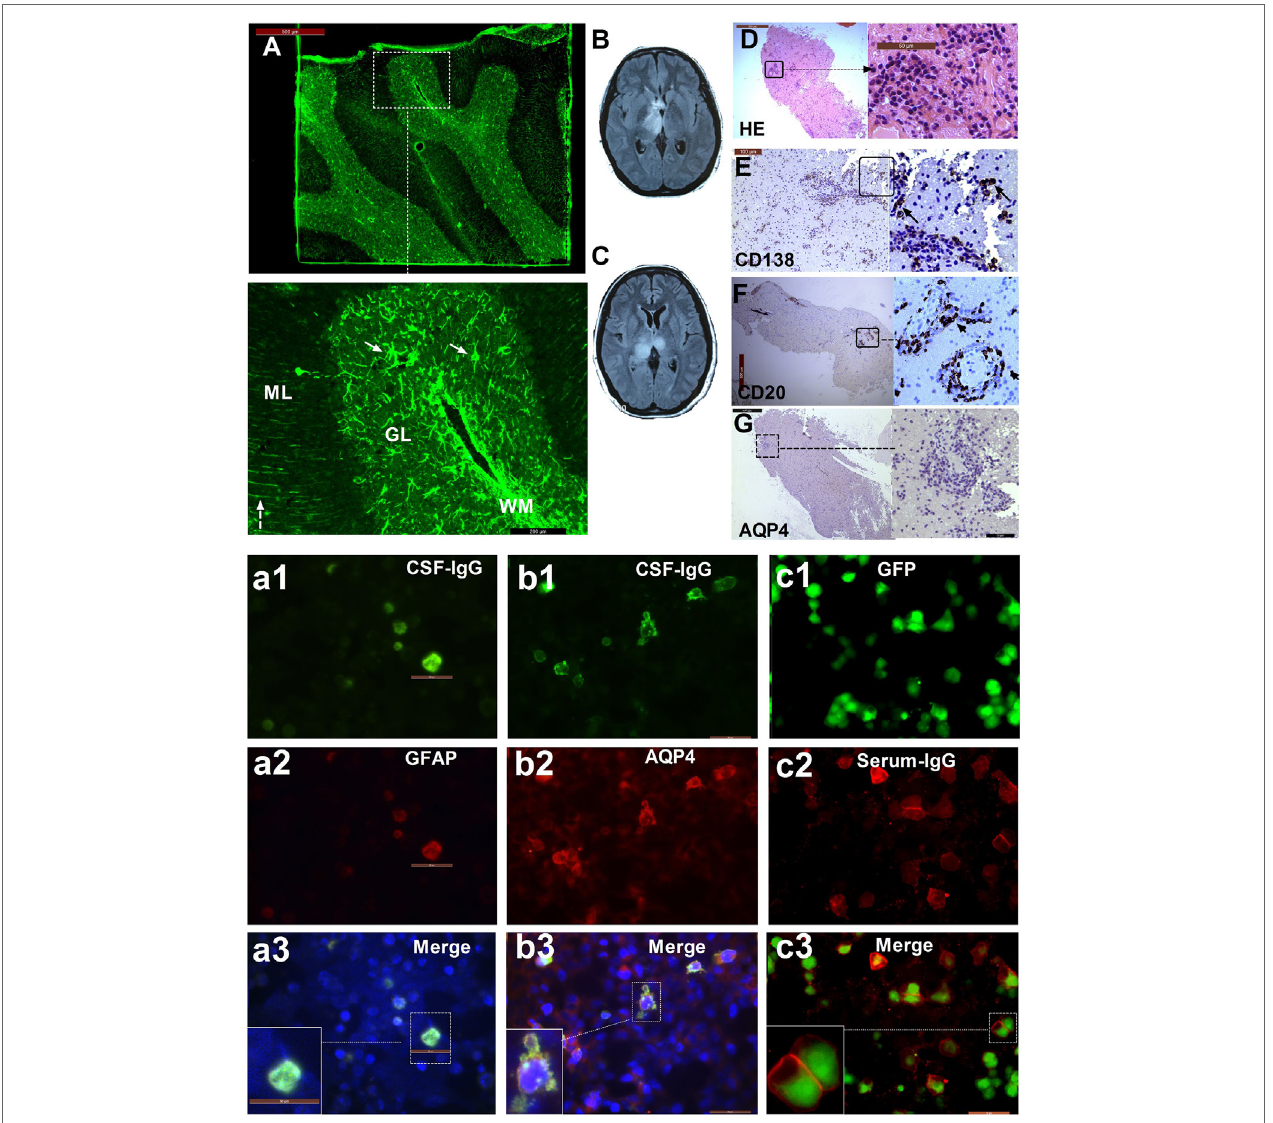
FigUre 1 | The patient with three types of antibodies: immunofluorescence pattern, magnetic resonance imaging (MRI), and neuropathological features. (a) Cerebellum section showing strong immunofluorescence in astrocytes (arrow) in white matter (WM), the granular layer (GL), and the molecular layer with a Bergmann radial pattern (dashed arrow); (a1) CSF-IgG bound to HEK293 cells transfected with GFAP ε , showing the microfilament pattern (green); (a2) glial fibrillary acidic protein (GFAP) α (red) expression in HEK293 cells transfected with GFAP α , showing the microfilament pattern; (a3) merged image from (a1) and (a2) . (b1) CSF-IgG bound to HEK293 cells transfected with AQP4 (green); (b2) AQP4-M23 protein (red) expression in HEK293 cells transfected with AQP4; (b3) merged image from (b1) and (b2) . (c1) HEK293 cells stably expressing green fluorescent protein (GFP)-tagged myelin oligodendrocyte glycoprotein (MOG) isoforms (green); (c2) transfected cells immunostained with human IgG (red); (c3) merged image from (c1) and (c2) . (B) An MRI scanning shows lesions in the left thalamus and anterior commissure at the first attack. (c) Bilateral thalamus lesions at the third attack. (D) Hematoxylin-eosin staining of brain biopsy tissue shows